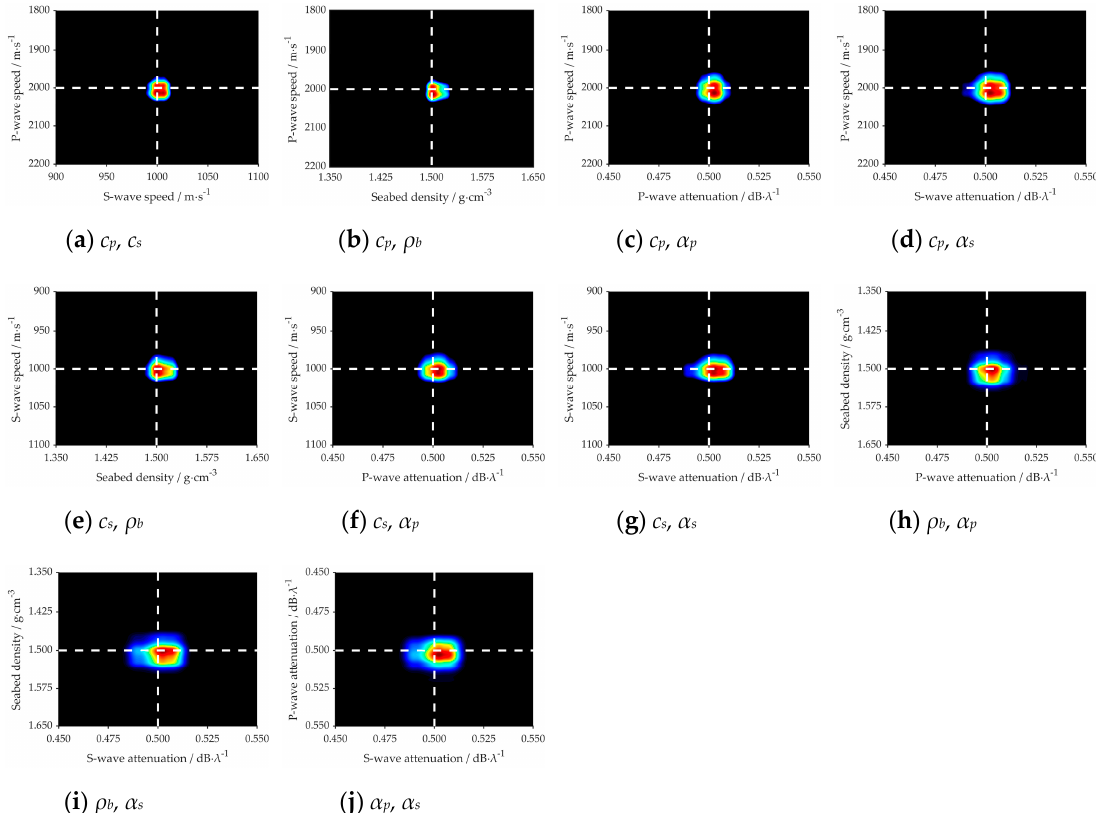
Figure 9. 2D marginal PPDs between different parameters in the noisy sea environment. White dashed lines mark the true values of each parameter in the simulation.